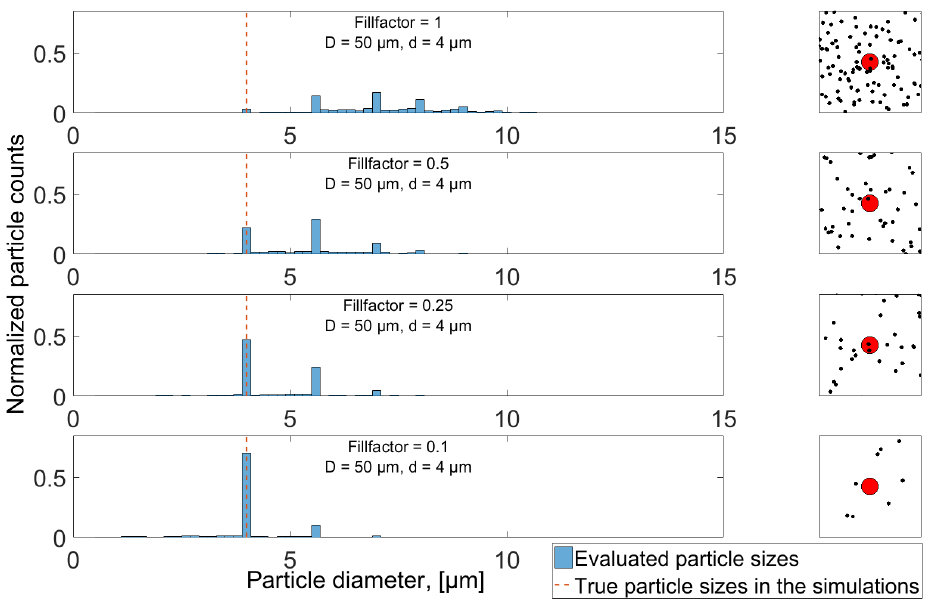
Figure 11. Evaluated particle counts when simulating 4µm particles at different concentrations. The insert shows an image of aperture and particle positions for a random sample. Histograms are normalized such that the sum of all bars equals 1, while bin widths are chosen for best graphical